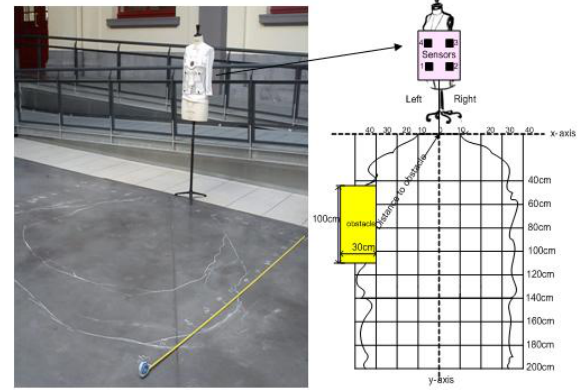
Fig. 13. Overview of experiment set-up for obstacle detection